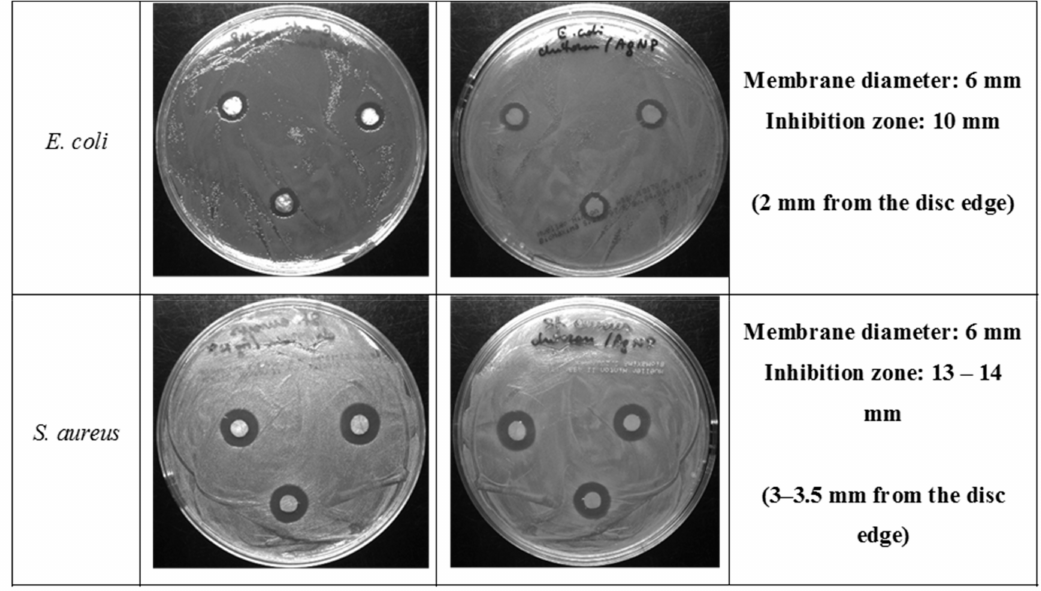
Figure 10. Photographs of the growth of E. coli ATCC 25922 and S. aureus ATCC 25923 on MH agar plates with placed discs cut from Ag / CS / SBA-15